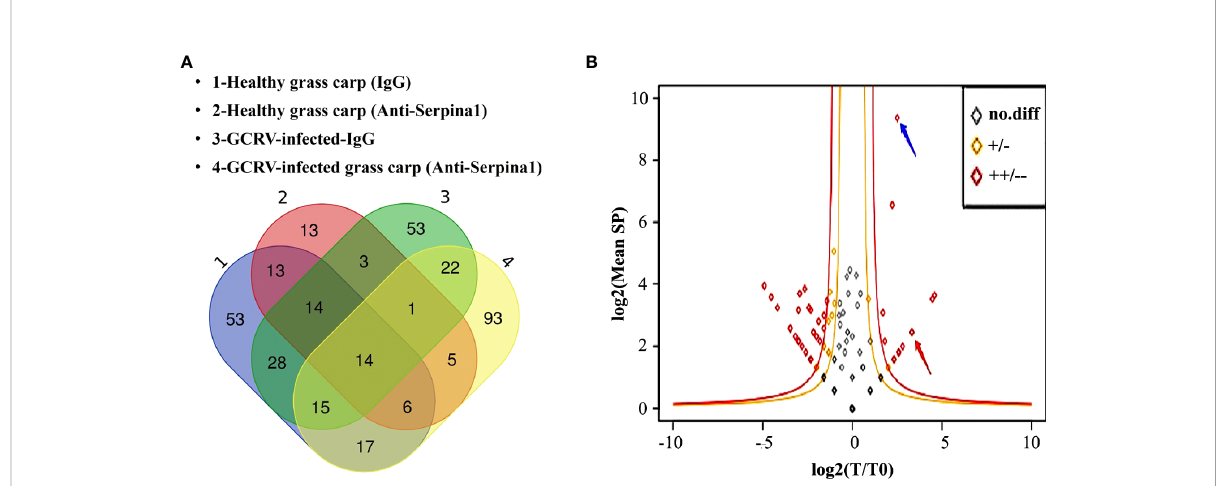
FIGURE 2 Screening of differentially bound proteins in mass spectrometry analysis. (A) Venn diagram of immunoprecipitated samples before and after the GCRV infection containing total protein classes. “ 1 ” represents negative control serum co-precipitated with healthy grass carp hepatopancreas tissue samples; “ 2 ” represents SERPINA1 antibody co-precipitated with healthy grass carp hepatopancreas tissue samples; “ 3 ” represents negative control serum co-precipitated samples with post-infected grass carp hepatopancreas tissue, and “ 4 ” represents SERPINA1 antibody co- precipitated samples with post-infected grass carp hepatopancreas tissue. (B) Scatter plots of differentially bound proteins. The outer red line is the highly signi fi cant difference interval. The blue arrows point to SERPINA1, and the red arrows point to CF2. The horizontal coordinates indicate the logarithm of the ratio of SERPINA1 antibody to the number of protein pro fi les in the hepatopancreas tissues of grass carp before and after GCRV infection. The vertical coordinates indicate the logarithm of the mean number of protein spectral counts in each